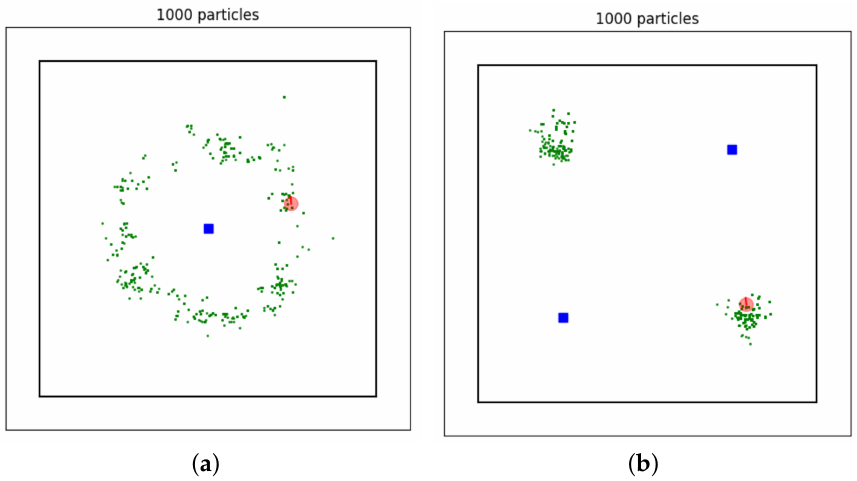
Figure 4. Simulation environments with different numbers of landmarks (blue rectangles). The range only measurements do not provide sufficient information for uniquely finding the true robot pose (red). The particles (green dots) converge to a more complicated posterior distributions. ( a ) One landmark: donut-like shaped posterior. ( b ) Two landmarks: bimodal